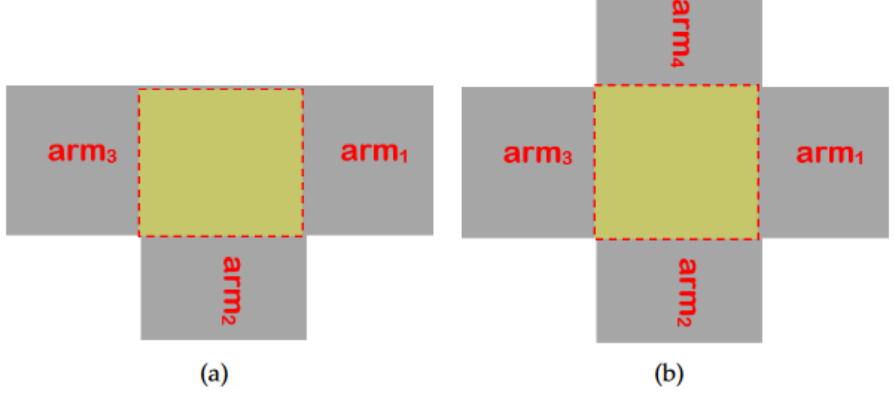
Figure 2. These figures depict the intersection arms of a three-way ( a ) and a four-way ( b )